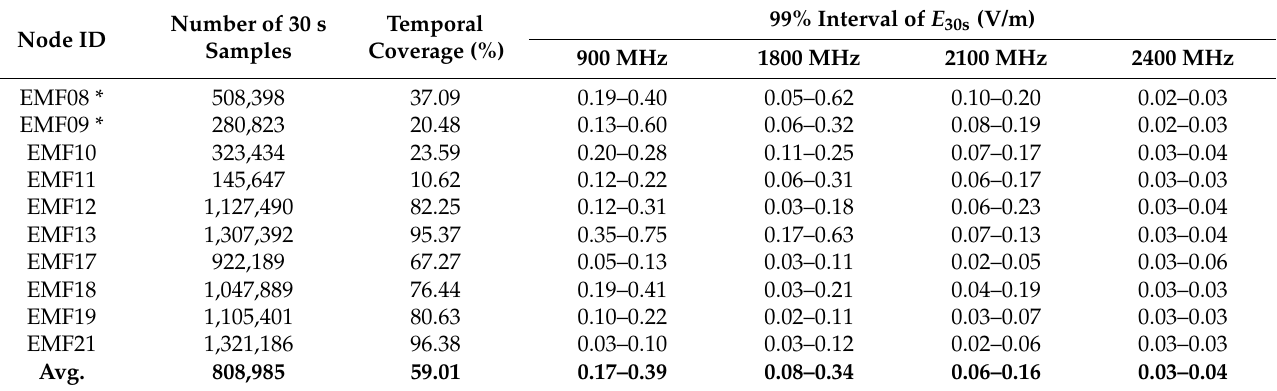
Table 2. Number of 30 s samples (and corresponding temporal coverage or relative on-time) and the 99% interval (0.5th to 99.5th percentiles) of the electric field values E 30s (in V/m) measured by the ten fixed RF sensor nodes in the IMEC City-of-Things network in Antwerp, Belgium. For each validated sensor (all nodes except EMF08 and EMF09), the individual offsets compared to the SRM validation setup were added to the measurements to better predict the exposure at ground level (see Appendix B).